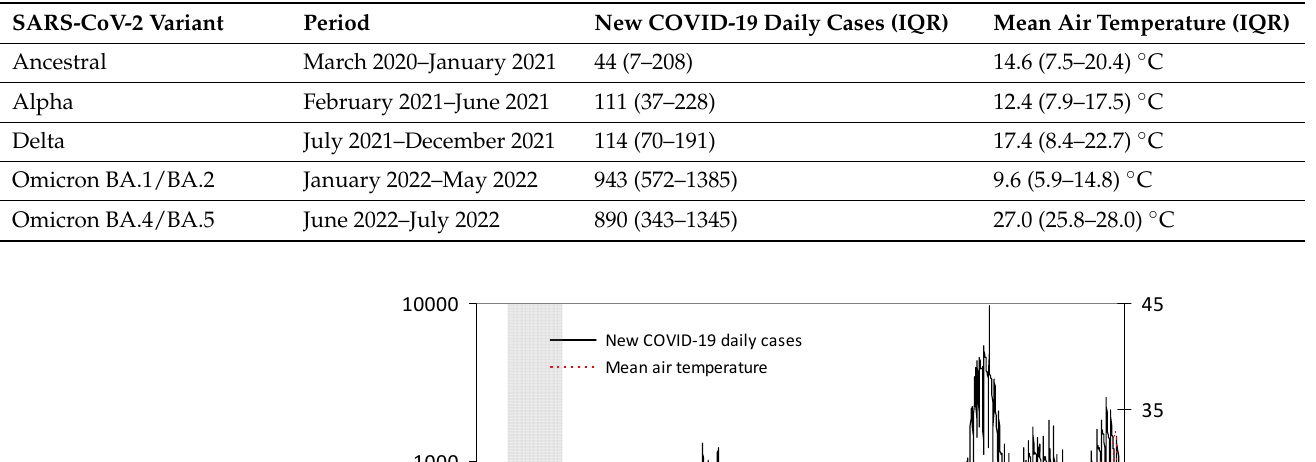
Table 1. Period of prevalence of different severe acute respiratory syndrome coronavirus 2 (SARS-CoV-2) variants in the province of Verona along with number of new daily COVID-19 cases and air temperature in the same area. Data are shown as median and interquartile range (IQR).